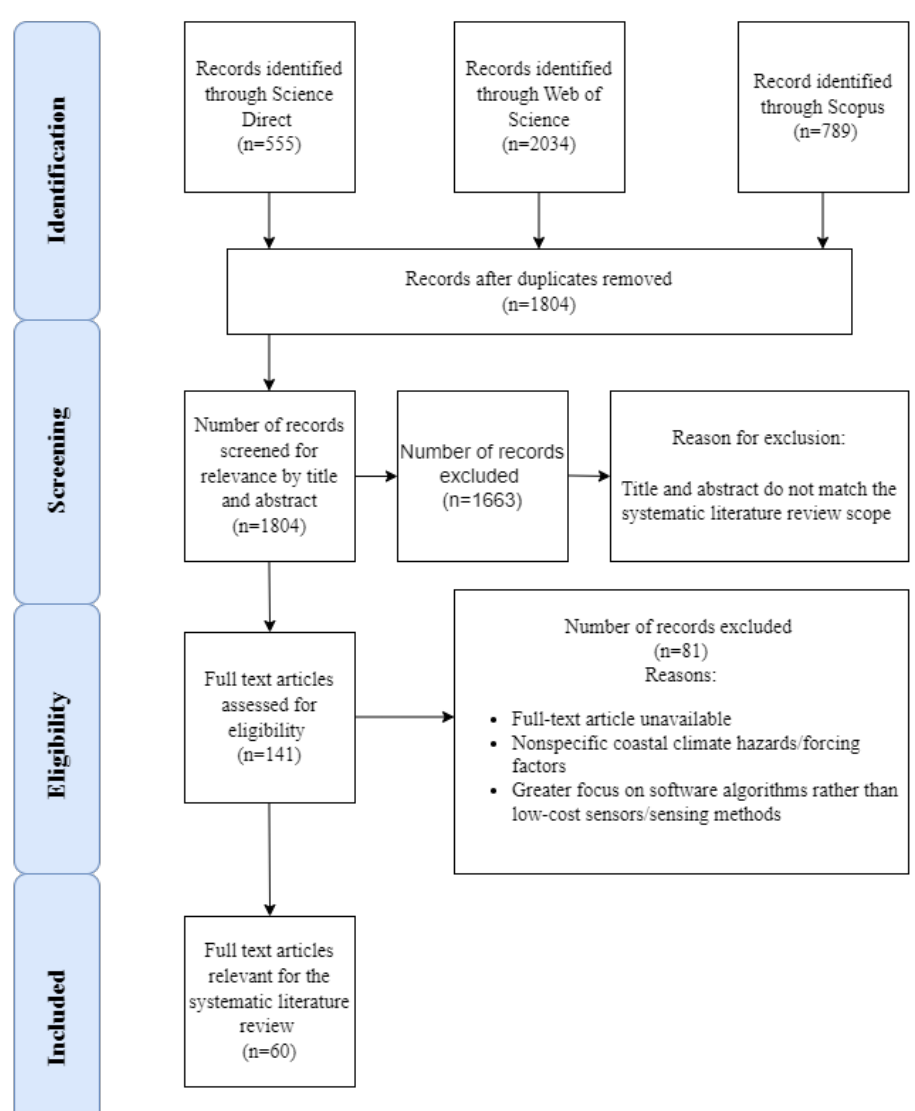
coastal climate Figure 1. PRISMA diagram for the systematic literature review on low-cost sensors for monitoring coastal climate hazards.